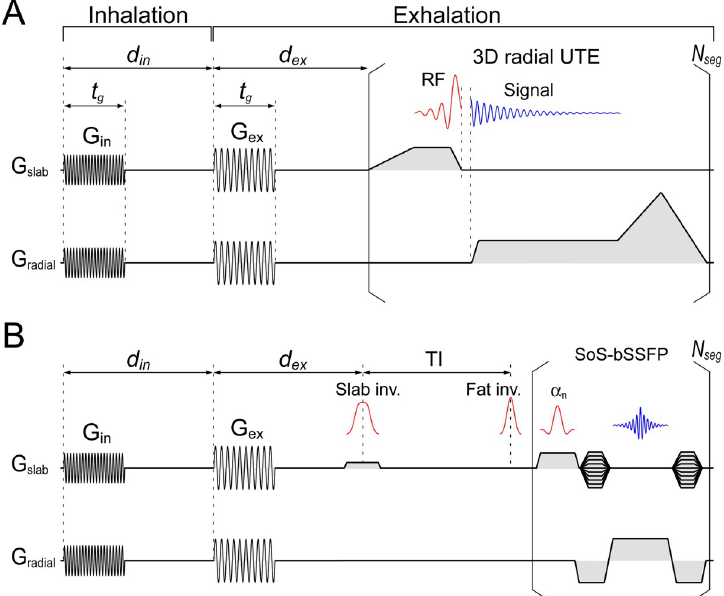
Fig 1. Sequence diagram of sequences with gradient-sound respiration guide. A) UTE sequence with sound-guided respiration. Respiration instruction sounds were generated by sinusoidal gradient waveforms, G in and G ex , with a duration t g = 400 ms; frequency of the gradient sound was set to 602 and 321 Hz for inhalation and exhalation instruction, respectively. Respiration was guided with 6 sec/breath, where 1.8 (= d inhalation and exhalation, respectively. Segmented UTE scan started at d exhalation instruction. B) Stack-of-stars balanced steady-state free precession (SoS-bSSFP) sequence with